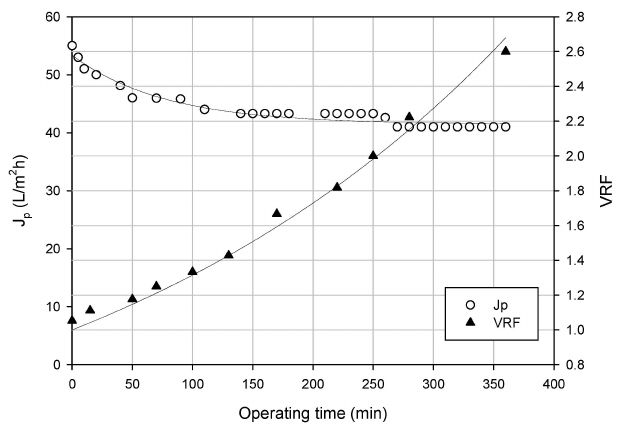
Figure 3. Clarification of orange press liquor by PVDF HF membranes according to the batch concentration mode. Time course of permeate fluxes and VRF (operating conditions: TMP, 0.6 bar; feed flow rate, 1200 mL/min; T, 25 ˝ C).